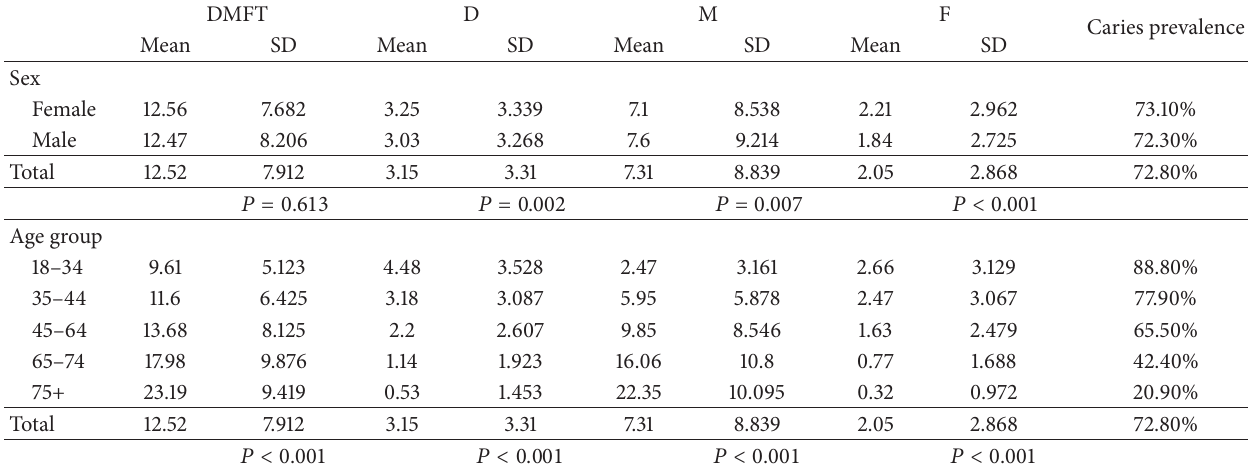
Table 3: DMFT, D, M, and F and caries prevalence according to sex and age